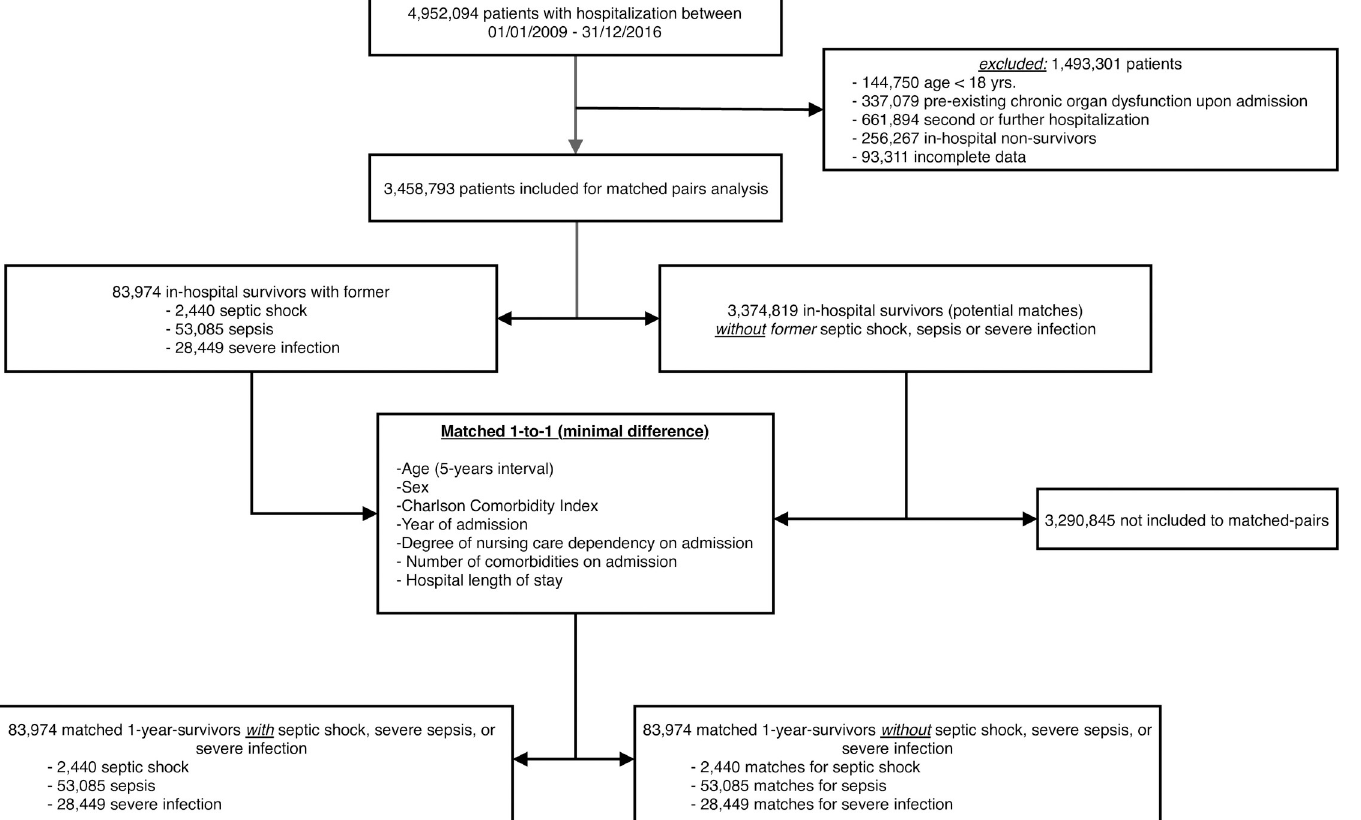
PLOS ONE | https://doi.org/10.1371/journal.pone.0228952 February 12,